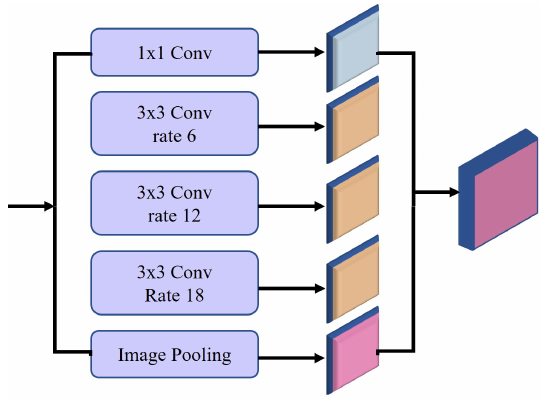
Figure 10. Atrous spatial pyramid pooling block.